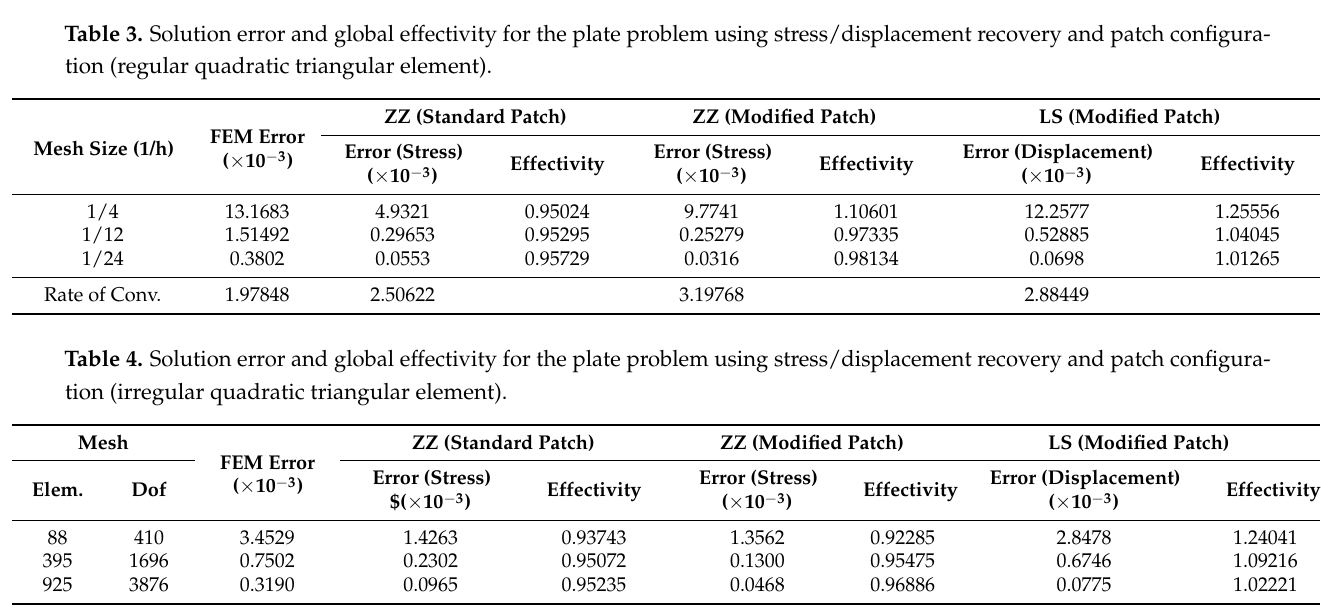
Table 5. Solution error and global effectivity for the plate problem using stress/displacement recovery and patch configura- tion (regular linear quadrilateral element).